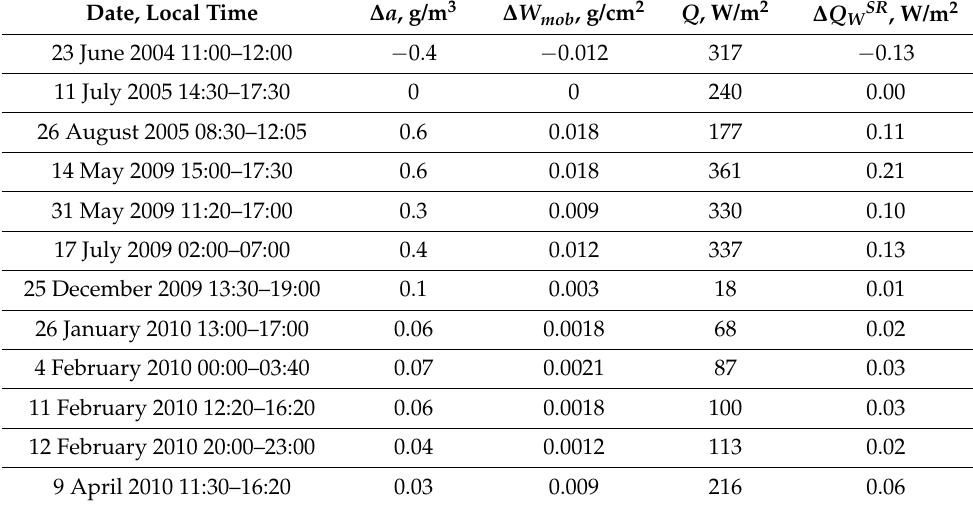
Table 3. Estimates of ∆ Q W SR from measurements of the mobile